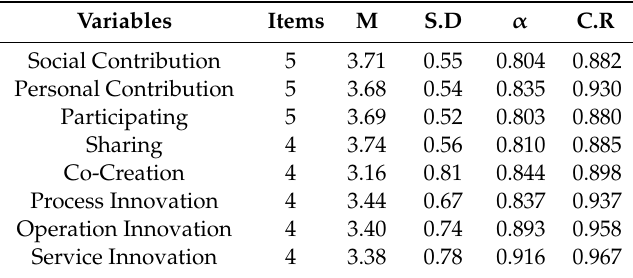
Table 4. Internal consistency of the constructs.